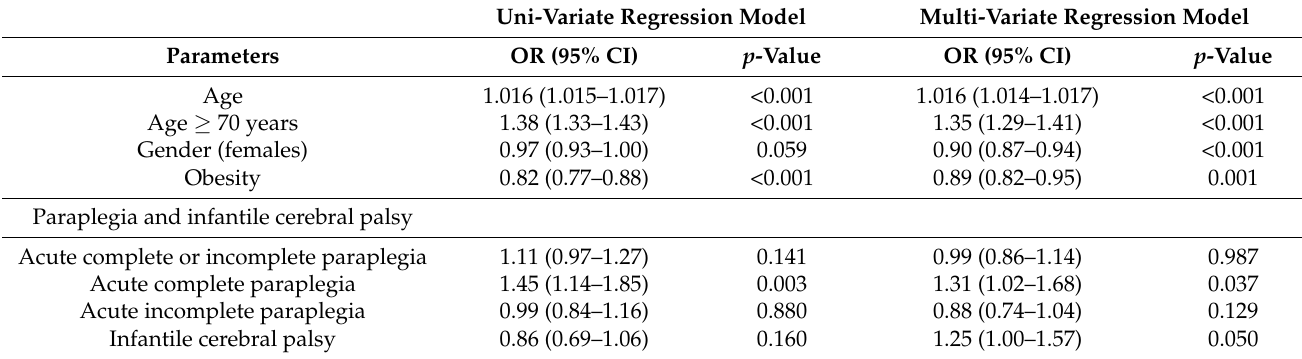
Table 4. Risk factors for in-hospital death in patients with paralysis in co-prevalence with venous thromboembolism. Uni-Variate Regression Model Multi-Variate Regression